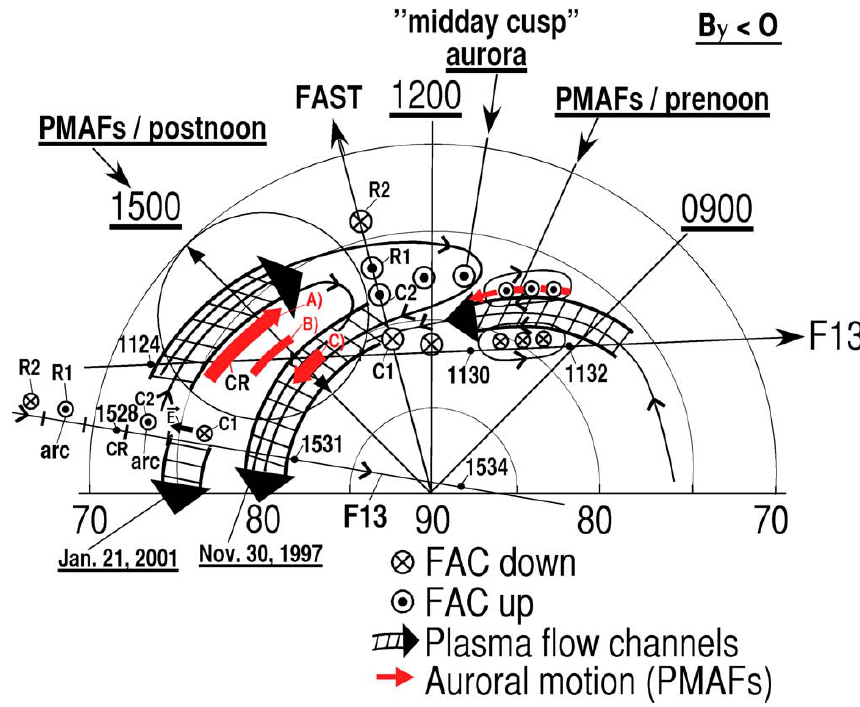
Fig. 19. Schematic illustration of plasma flow channels and aurorae located on newly open and old open field lines under IMF B y < 0 conditions. Flow channels FC 1 are characterized by noonward convections in the prenoon and postnoon sectors. FC 2 shows enhanced antisunward convection at dusk. The two FC 2 channels marked at dusk refer to two different days of observations (21 January 2001 and 30 November 1997). Auroral observations in the prenoon (PMAFs/prenoon) and postnoon (PMAFs/postnoon) sectors were obtained on 30 November 1997. Tracks of spacecraft DMSP F13 from dusk to dawn refer to two intervals on different days (11:24–11:32UT, 30 November 1997 and 15:25–15:34UT, 21 January 2001). Relationships between latitude profiles of Birkeland currents (C1-C2-R1-R2) and poleward moving auroral forms (PMAFs; marked red) are indicated. The coordinate system is MLAT/MLT. Dusk is to the